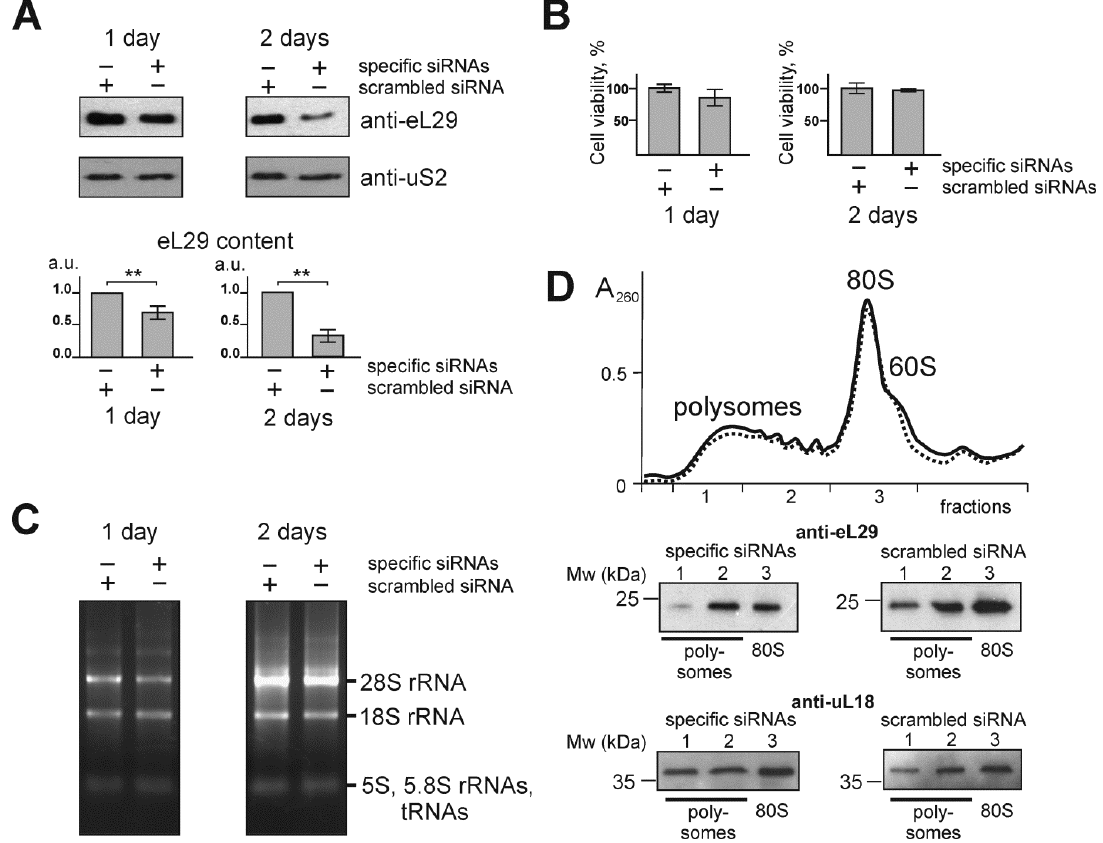
Figure 1. Characterization of HEK293 cells knocked down of ribosomal protein eL29. ( A ) Western blot analysis of the levels of ribosomal proteins eL29 and uS2 (as a reference) in cells transfected with siRNAs specific for eL29 mRNA with scrambled control, 1 and 2 days after transfection. The diagrams show the western blot data in triplicate as the mean of arbitrary units (a.u.) ± CEM (** p < 0.01, calculated using Student’s t-test). ( B ) Histograms of MTT assay of cells transfected with scrambled or eL29 mRNA-specific siRNAs. ( C ) Electrophoretic analysis of total RNA samples extracted from cells transfected with the above siRNAs on a 0.5% agarose gel stained with ethidium bromide. ( D ) Polysome profiles obtained by centrifugation of lysates of cells transfected with scrambled (solid line) and eL29 mRNA-specific (dashed line) siRNAs in sucrose density gradient with marked peaks corresponding to 60S subunits, 80S ribosomes and polysomes. Western-blot analysis of gradient fractions for the presence of eL29 and uL18 (as a reference). Lanes 1, 2 and 3 correspond to the sucrose gradient fractions containing “heavy” polysomes ( > 5 ribosomes per mRNA), “light” polysomes ( ≤ 5 ribosomes per mRNA) and 80S ribosomes (together with a small portion of 60S subunits), respectively.